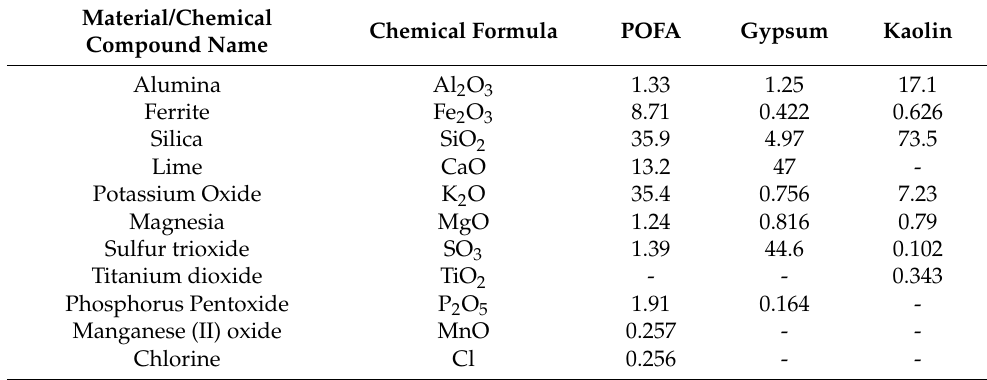
Table 1. Chemical Properties of POFA, gypsum and kaolin.